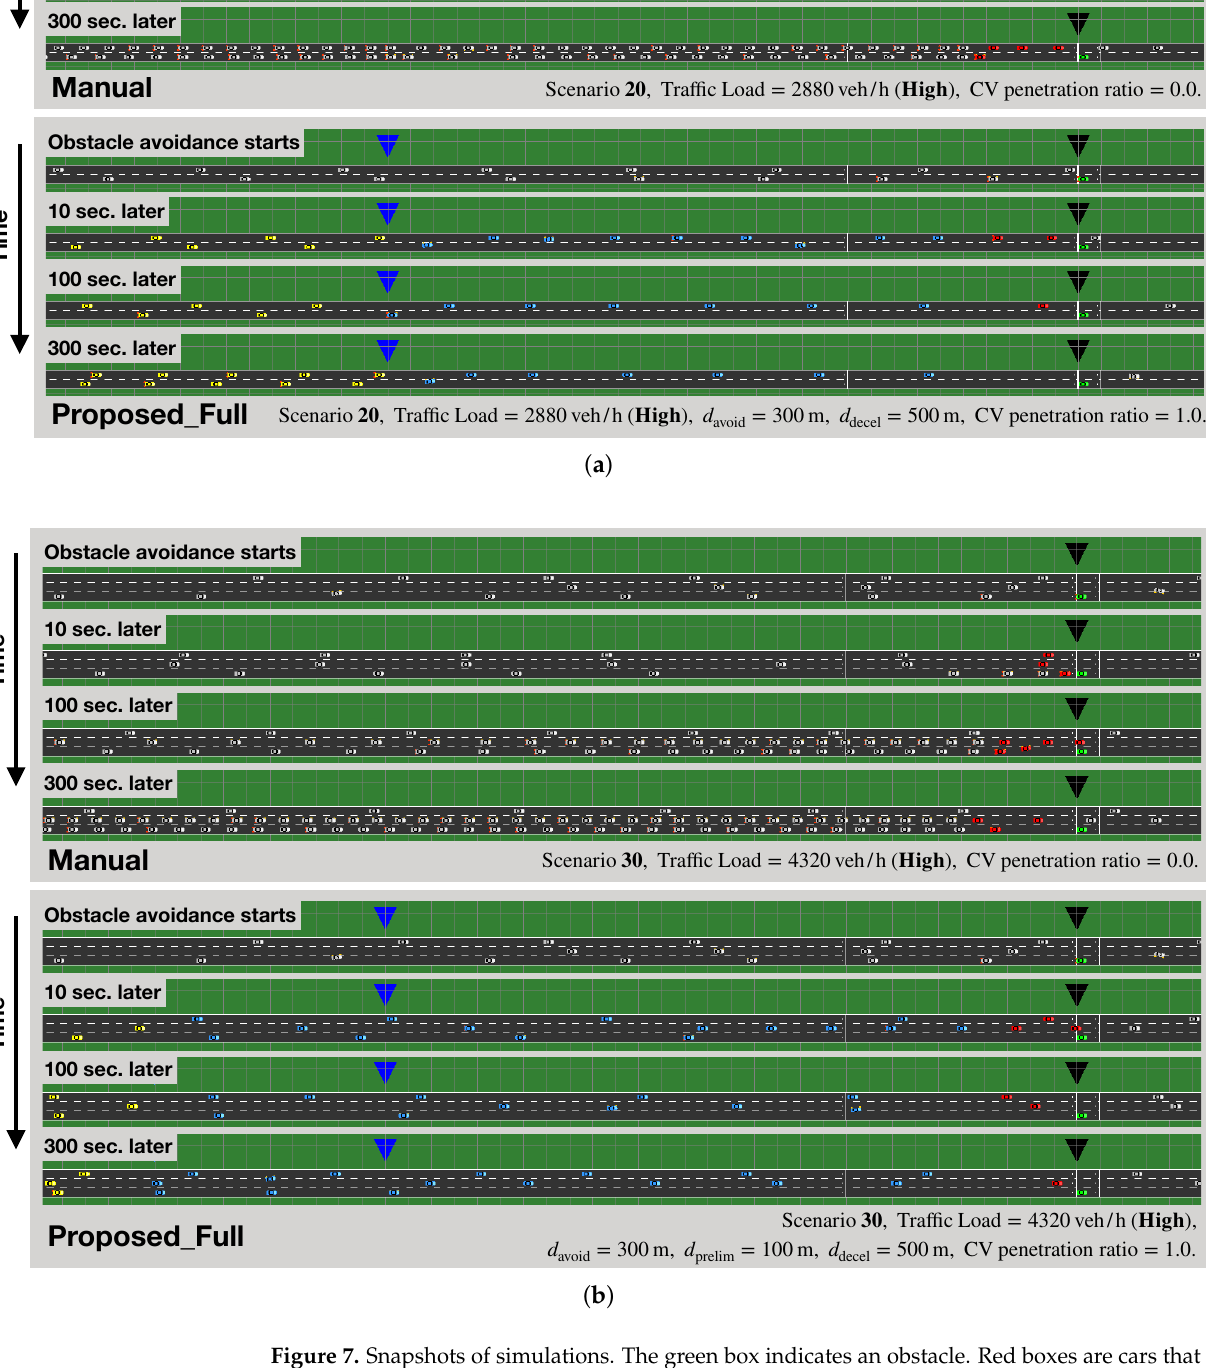
Figure 7. Snapshots of simulations. The green box indicates an obstacle. Red boxes are cars that have detected the obstacle directly. ( a ) Simulations of obstacle avoidance in Scenario 20. ( b ) Simulations of obstacle avoidance in Scenario